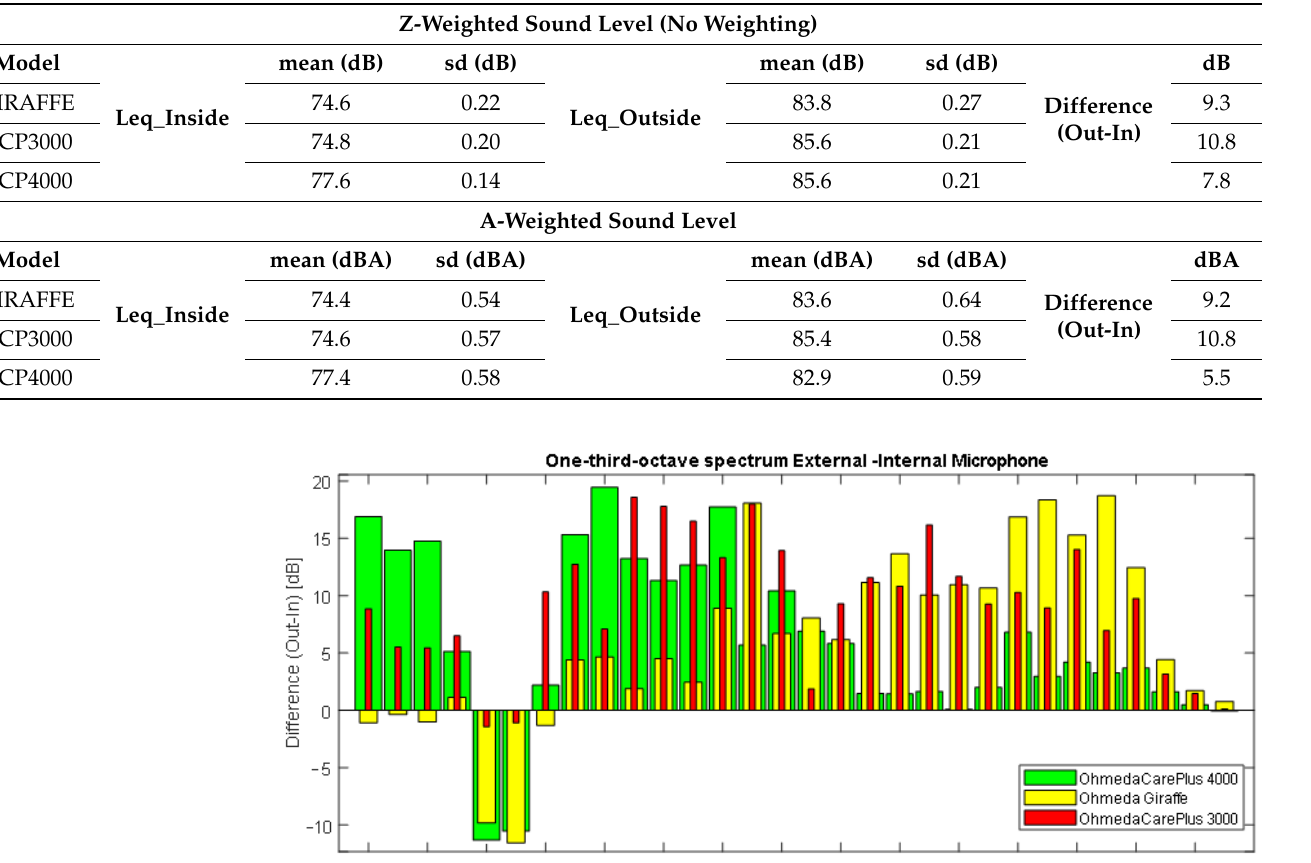
Table 3. The overall noise level inside and outside the incubators (Incubators off; external sound source on).